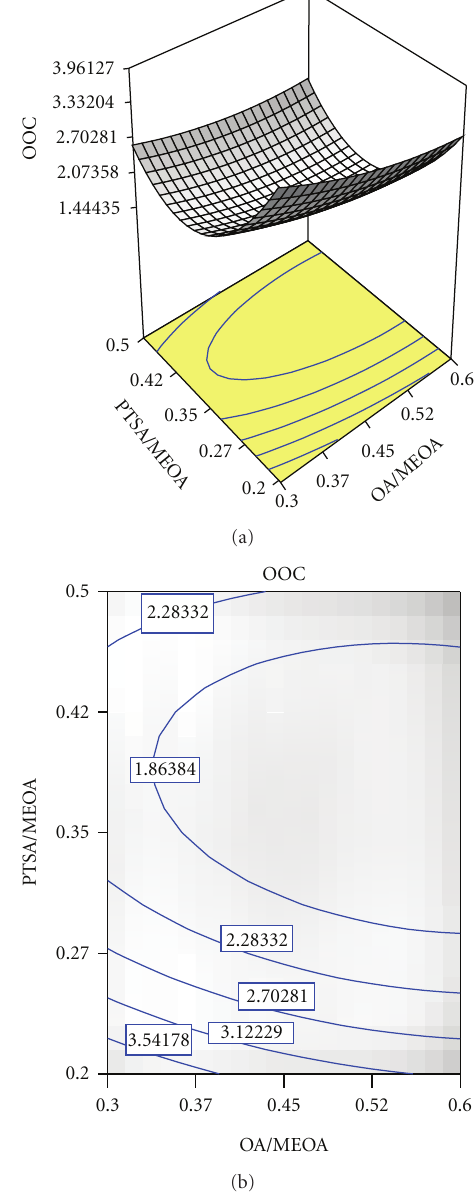
Figure 2: Response surface (a) and contour plots (b) for the e ff ect of the OA/MEOA ratio ( X 1 , w/w) and PTSA/MEOA ratio ( X 2 , w/w) on the OOC% of